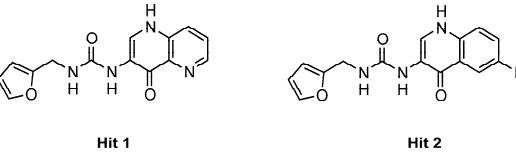
Figure 1. Chemical structures of Hits 1 and 2 .